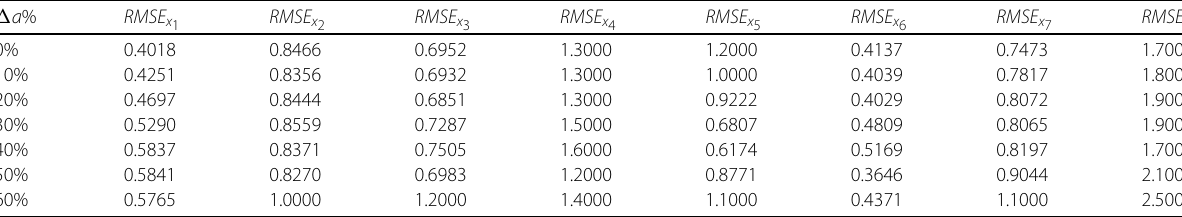
Table 2 Tracking RMSE × 10 –3 for the robotic tower crane in the case of disturbances (cid:7) a %